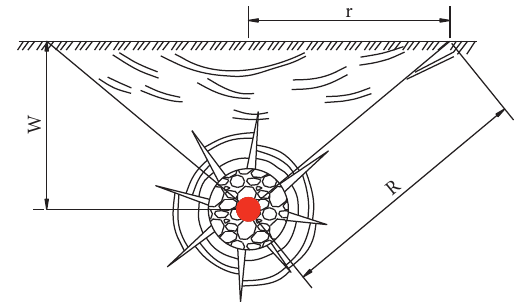
Figure 2: Blasting crater formation schematic diagram. W: min- imum resist line; R: broken radius; r: blasting crater radius. Roadway